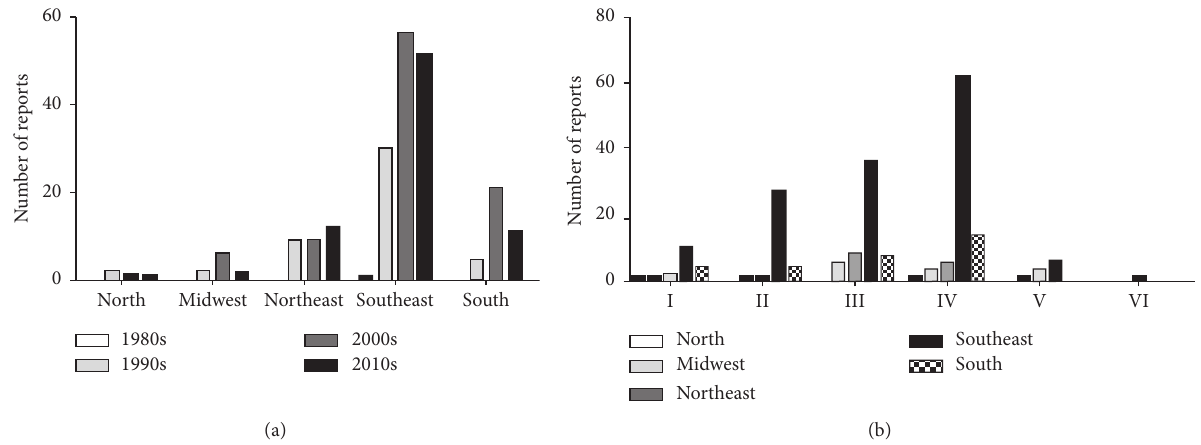
Figure 5: MRSA isolates and the types of SCCmec reported in Brazil. (a) Numbers of MRSA isolations per decade in the five regions of Brazil. (b) Numbers of types of SCC mec reported in the five regions of Brazil until 2019. The graphics program used to create the figure was GraphPad